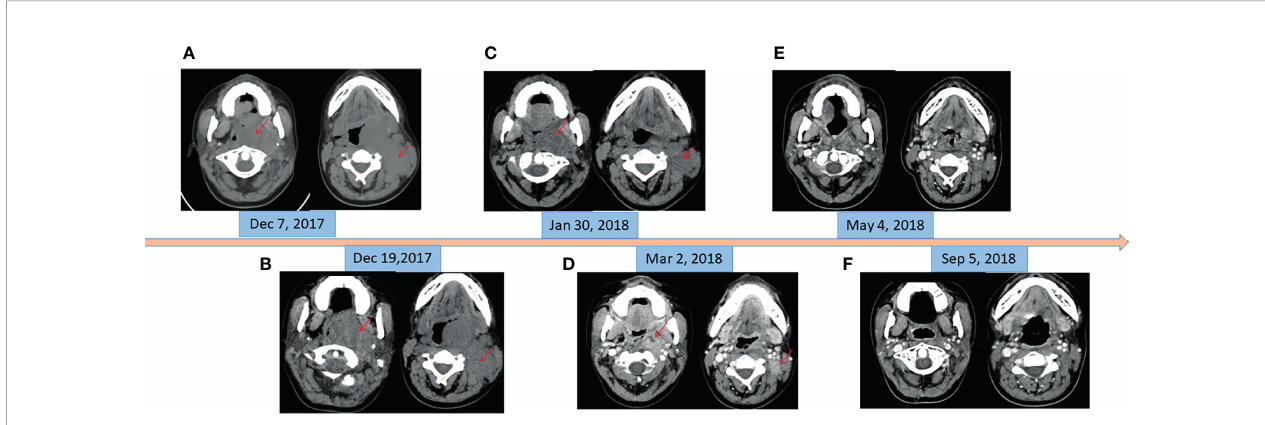
FIGURE 1 | CT imaging of changes of masses in oropharynx and leftneck. (A) Before chemotherapy (pharyngeal mass: 6.0 cm × 4.6 cm; neck mass: 3.9 cm × 2.9 cm). (B) Atthe beginningof radiotherapyand 11 days after chemotherapy (pharyngeal mass: 6.0 cm × 4.4 cm; neck mass: 3.5 cm × 2.8 cm). (C) At the end of the radiotherapy andoral crizotinib for 1 month (pharyngeal mass: 4.3 cm × 2.7 cm;neckmass: 2.6 cm × 1.4 cm). (D) At the beginningof oral imatinib and thalidomide(pharyngeal mass: 2.8 cm × 1.9 cm;neck mass: 2.1 cm × 1.4 cm). (E) Oral imatinib and thalidomidefor 2 months. (F) Oral imatinib and thalidomidefor 6